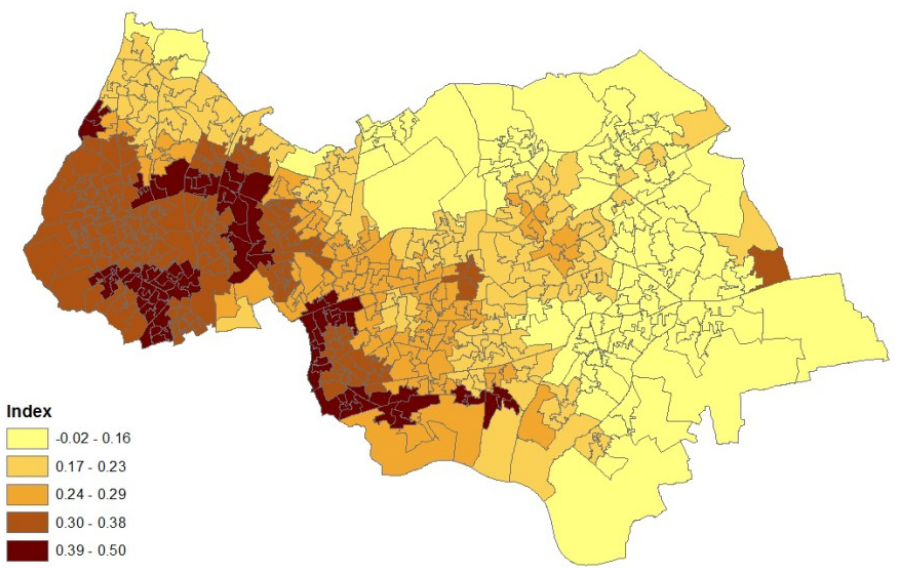
Figure 2. Index of low air quality, LSOAs, outer NE